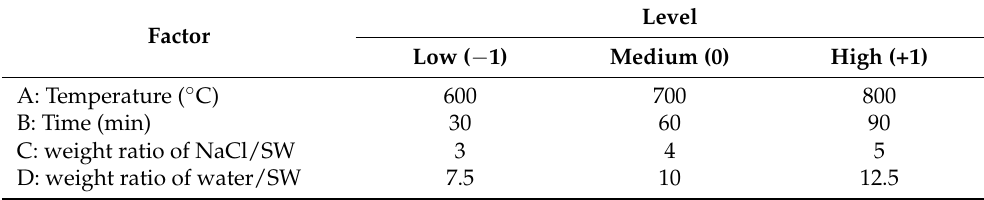
Table 1. The range and levels of the experimental variables investigated in this study.